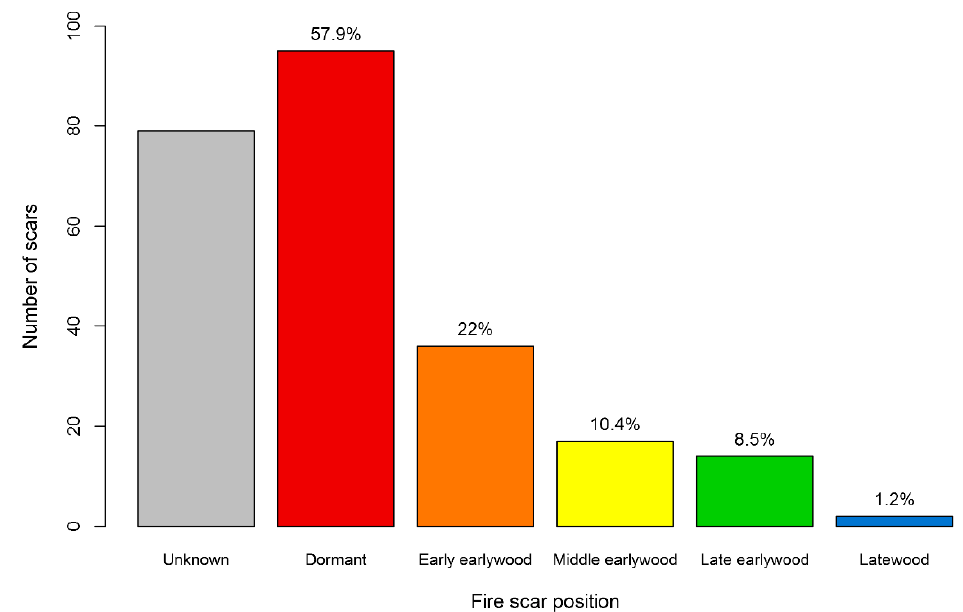
Figure 5. The distribution of fire-scar intra-ring positions (seasonalities) in the Taos Valley Watersheds (1390–1899, n = 243 fire scars). We could not determine the season for 32% of the scars (Unknown). The percentages above the bars are calculated from the total number of scars with a season determined. Dormant scars occurred at the beginning of the growing season (likely May or June), and latewood scars occurred at the end of the growing season (likely September or October).